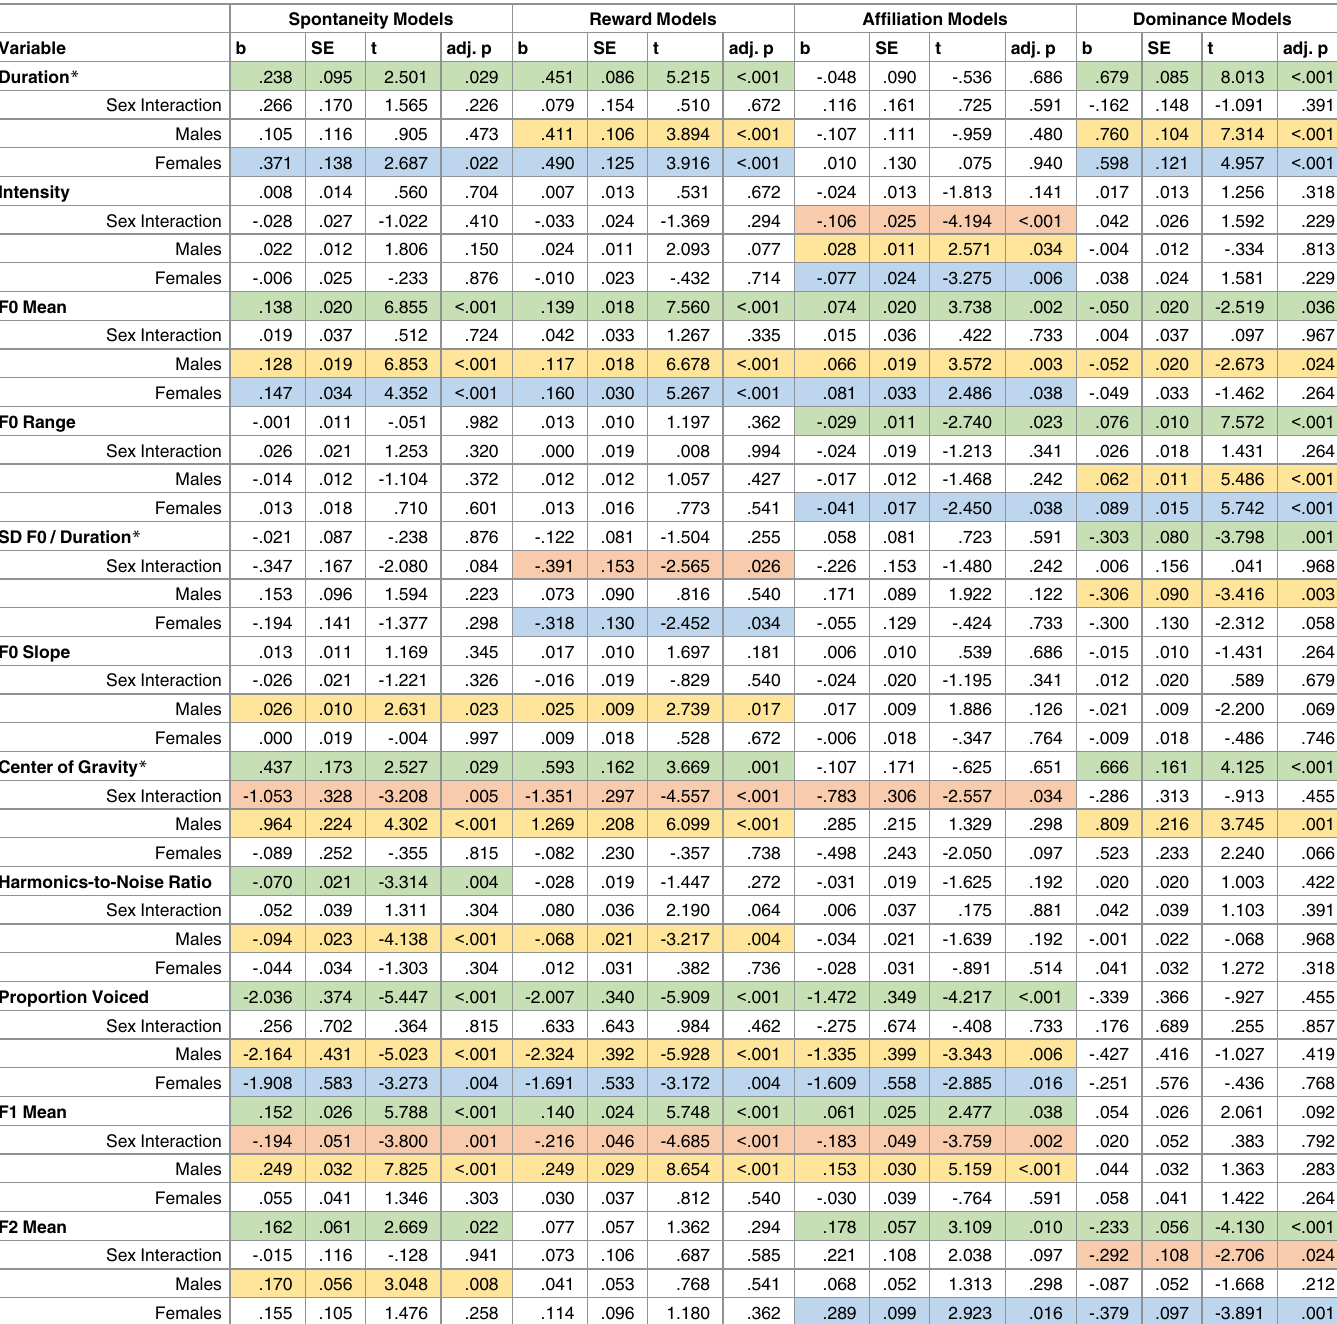
Table 4. Model estimatesfrom LMEMs predicting social judgments from acoustic variables and their interactions with actor